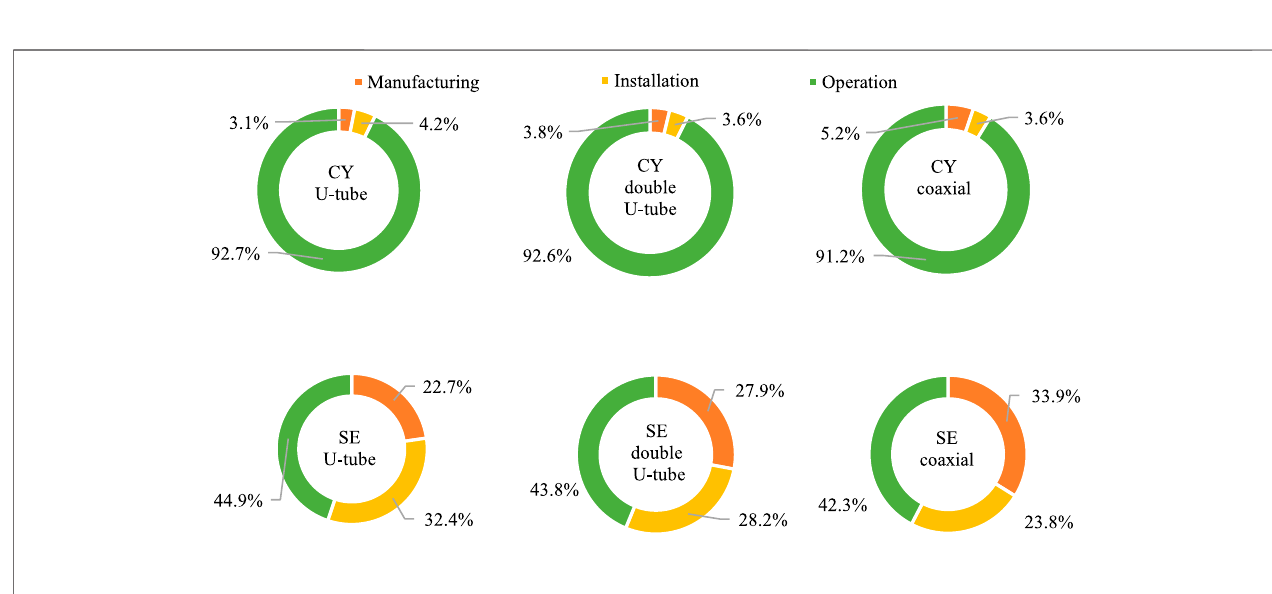
FIGURE 5 | Percentage share of the different processes for the GWP impact per FU in two different cases/countries, CY (top row) and SE (bottom row), for single U-tube GHE ( fi rst column), double U-tube GHE (middle column), and coaxial GHE con fi gurations (last column).